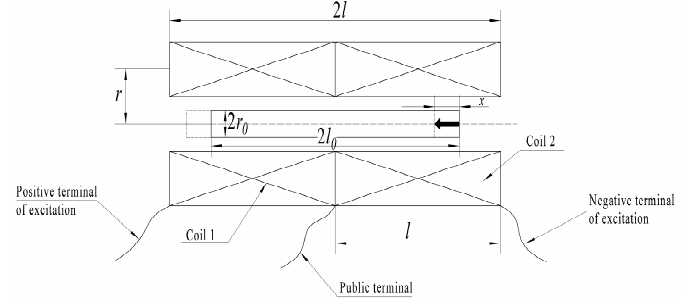
Figure 3. Structure parameters of the coil.